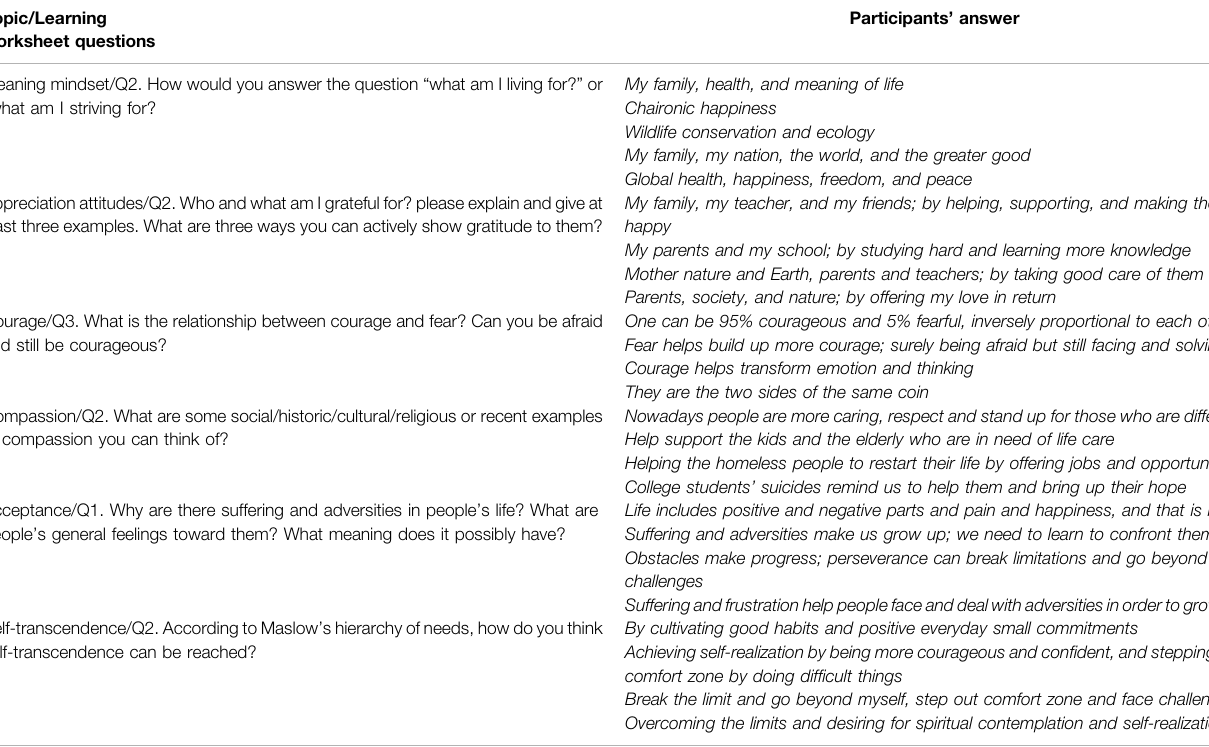
TABLE 4 | The examples of students ’ weekly learning sheet feedback on CasMac